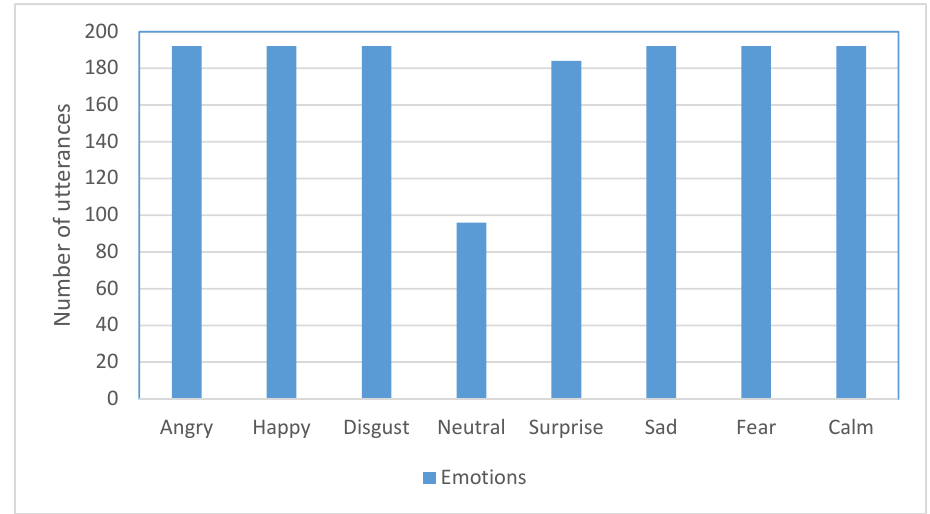
Figure 1. The Ryerson audio-visual database of emotional speech and song (RAVDESS).